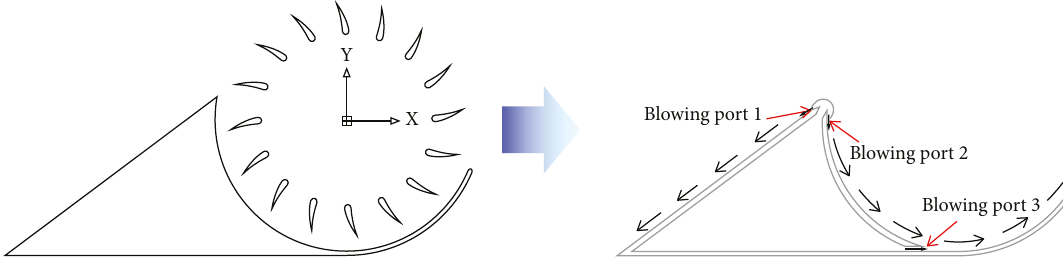
Figure 2: Evolution of the Fan-wing airfoil to evolution of the DJBW